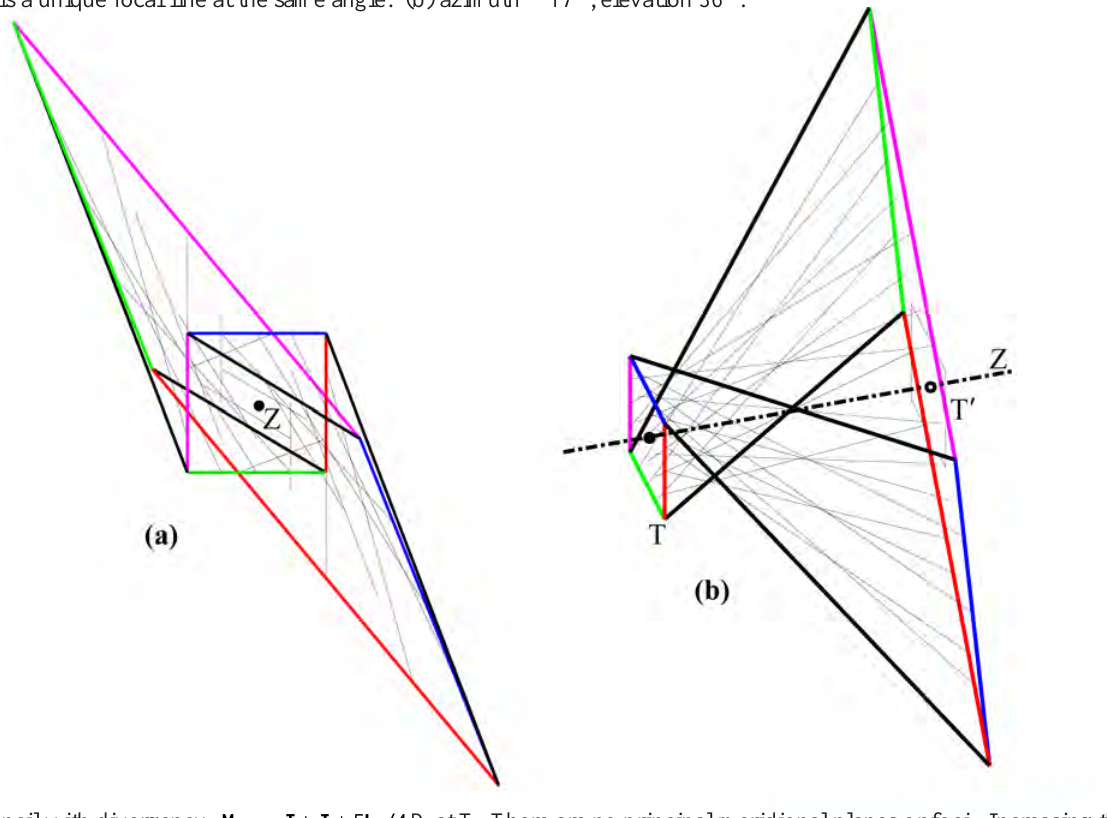
Figure 21 A pencil with divergency 4/5 LJIM ++−= D at T. There are no principal meridional planes or foci. Increasing the antistigmatic component of the divergency still further relative to that in Figure 20 has removed the line focus. (b) azimuth °− 20 17 °− 20 , elevation 36 °− 20